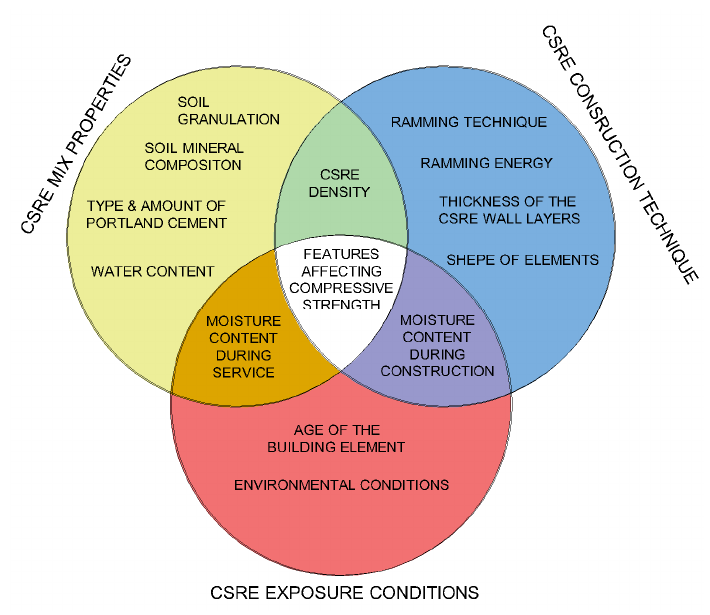
ff ecting the compressive strength and durability of Figure 1. Proposed features affecting the compressive strength and durability of CSRE. Figure 1. Proposed features a